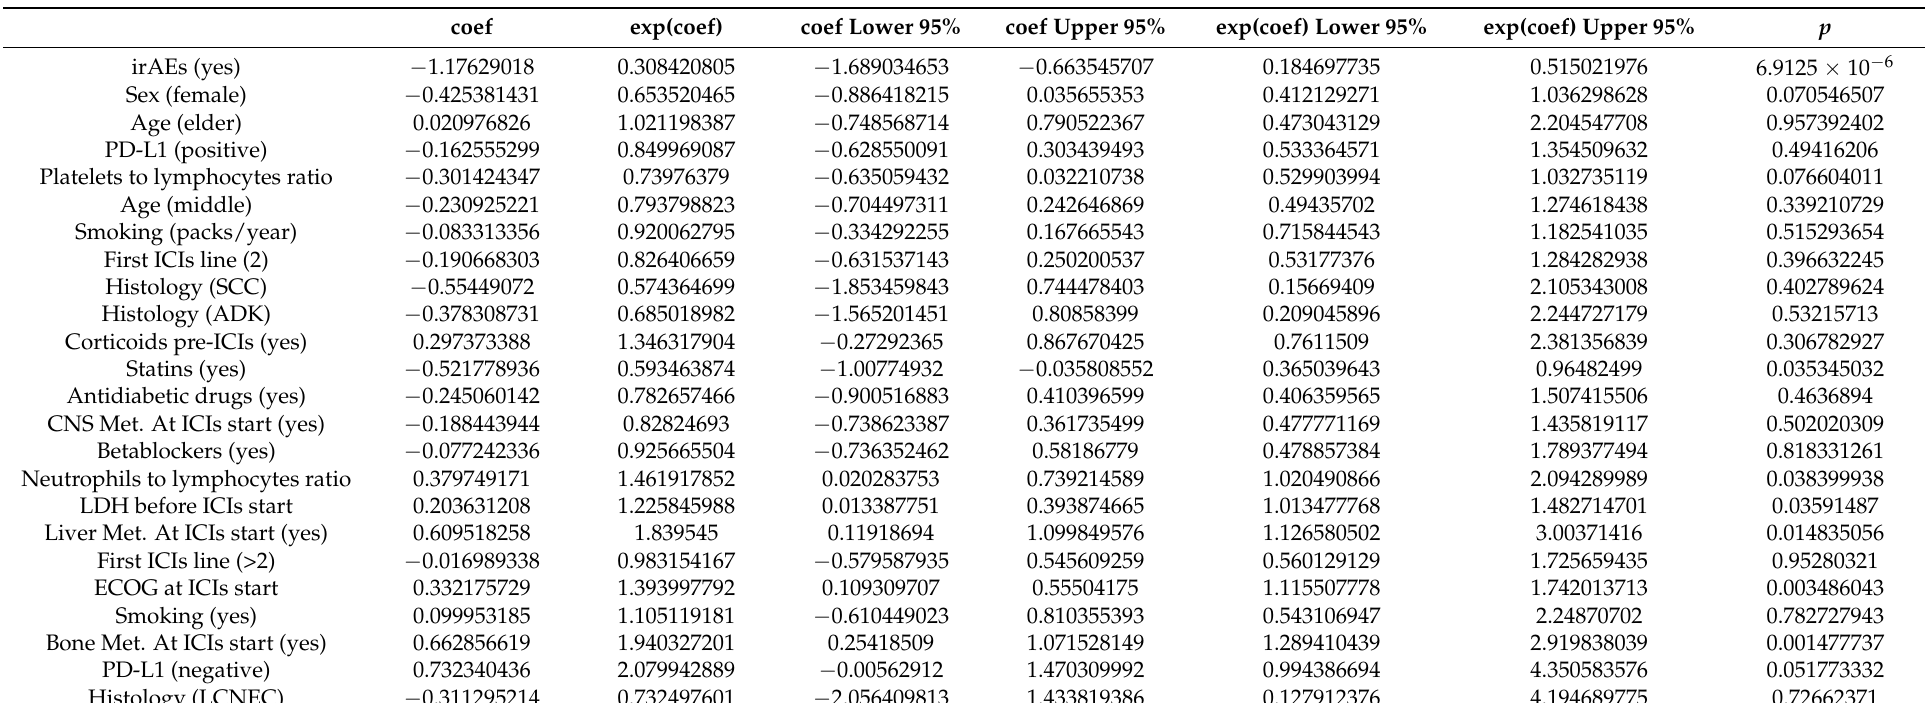
Table 3. Multivariate Cox proportional-hazards survival